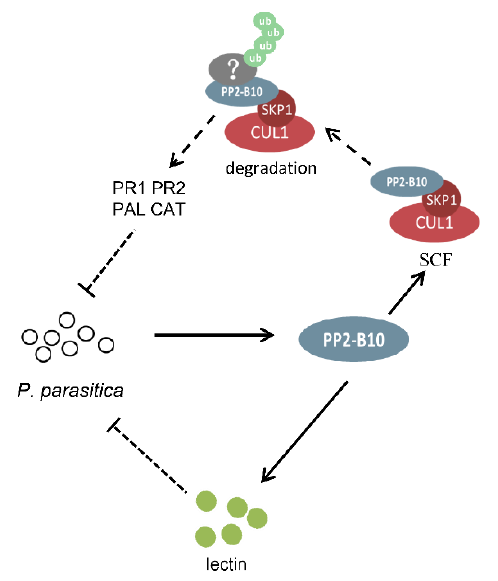
Figure 7. Model of the NpPP2-B10-mediated positive regulation of the plant defense response. The solid line represents our experimental results, and the dotted line represents our presumed path- way.